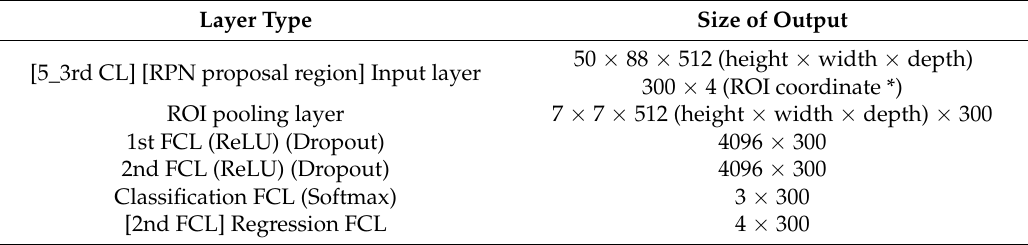
Table 4. Architecture of classifier in Figure 5 (ROI coordinate * includes the values of x_min, y_min, x_max, and y_max of ROI for each proposal) (CL and FCL indicate convolutional layer and fully connected layer, respectively.).